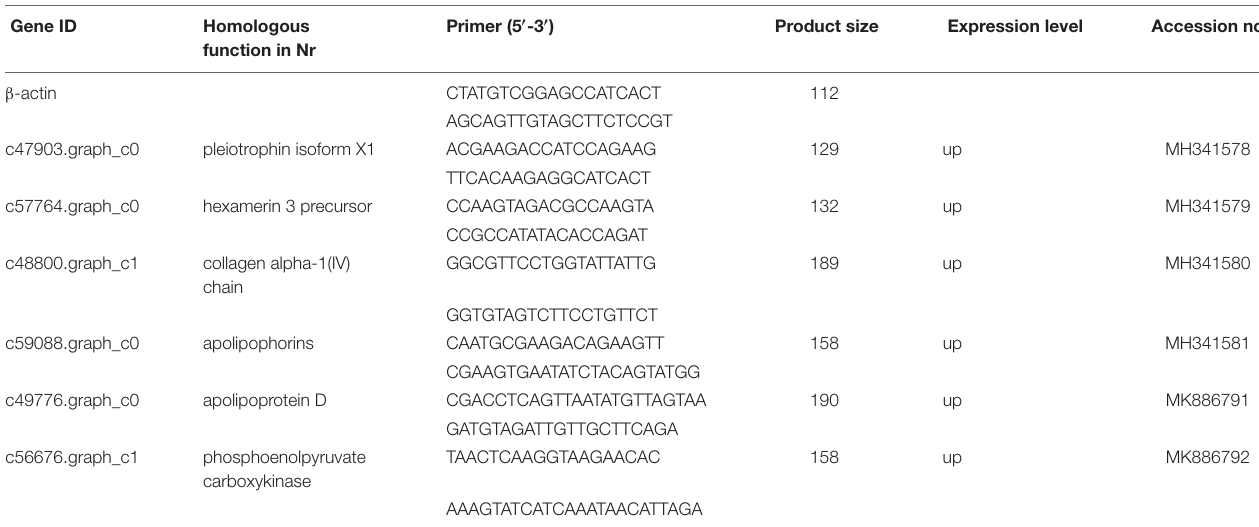
FIGURE 3 | Clusters of Orthologous Groups (COG) functional classification. The 1,471 sequences were classified into 25 COG categories. TABLE 5 | Sequences of the primers used for the qRT-PCR analysis of six randomly selected